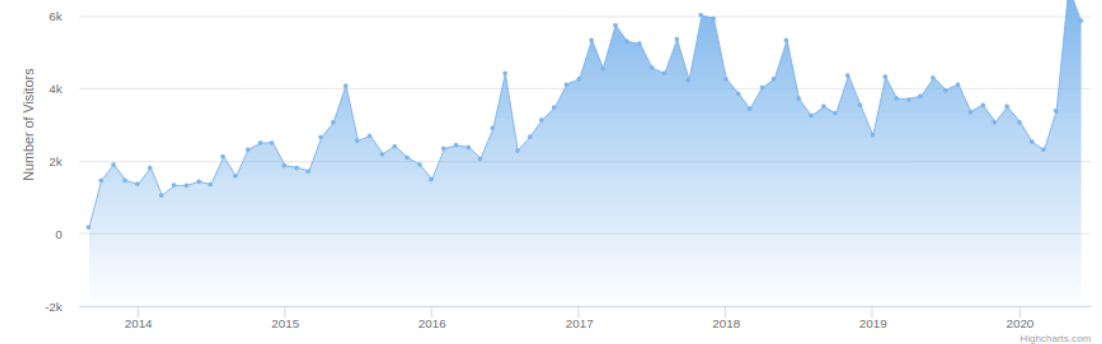
Figure 8. Statistics of monthly CRDB connections since August 2013. The peak in May 2020 is related to queries made for systematic checks before the release of CRDB v4.0 ; to a lesser extent, a similar peak is visible in August 2016 related to the release of CRDB v3.0 . In CRDB v4.0 , this traffic plot is now accessible for any user via a link in the ‘Welcome’